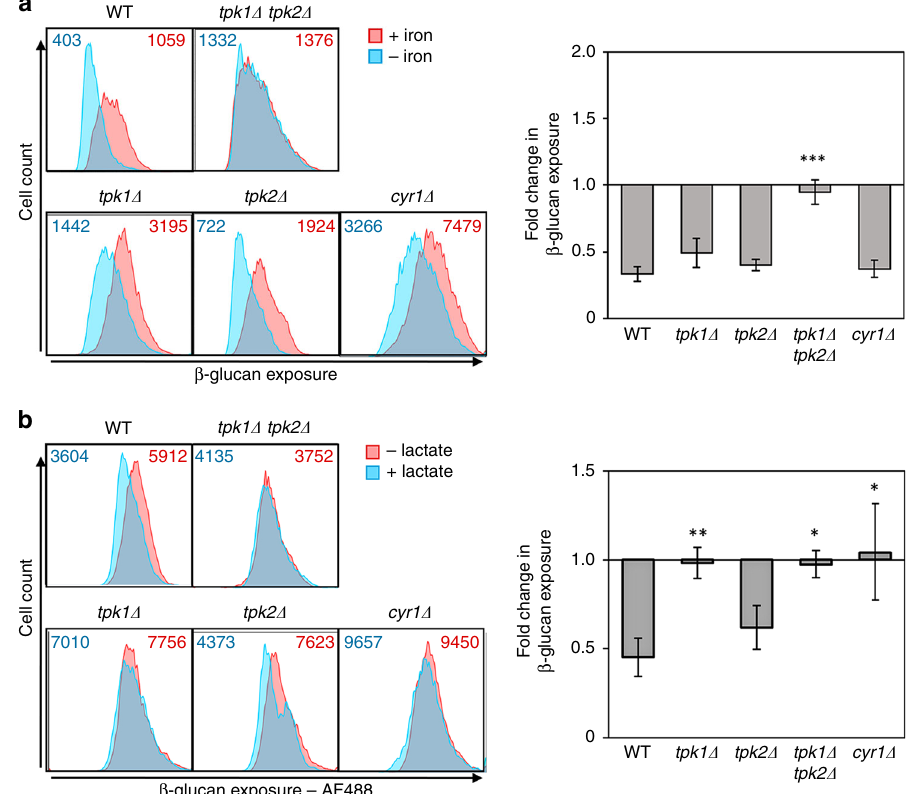
Fig. 6 Protein kinase A signalling mediates iron-limitation-induced β -glucan masking. a C. albicans strains were exposed to iron replete (pink) or iron deplete conditions (cyan) for 5 h, fi xed and stained with Fc-dectin-1, and their levels of β -glucan exposure quanti fi ed by cytometry: WT, wild type, SN152; tpk1 Δ ; tpk2 Δ ; tpk1 Δ tpk2 Δ ; cyr1 Δ , CR323 (Supplementary Table 1). Median fl uorescence intensities (MFIs) for the iron replete and iron deplete cell populations are shown. The right-hand panel shows the fold change in β -glucan exposure for each strain, calculated by dividing the MFI under iron-limiting conditions by the MFI for the corresponding control iron replete cells. b This experiment was performed for the same C. albicans strains grown on SD and exposed for 5 h to 0% or 2% lactate. Means and standard deviations from three independent replicate experiments are shown, and the data were analysed using ANOVA with Tukey ’ s multiple comparison test: * p < 0.05; ** p < 0.01; *** p < 0.001. Source data are provided as a Source Data fi